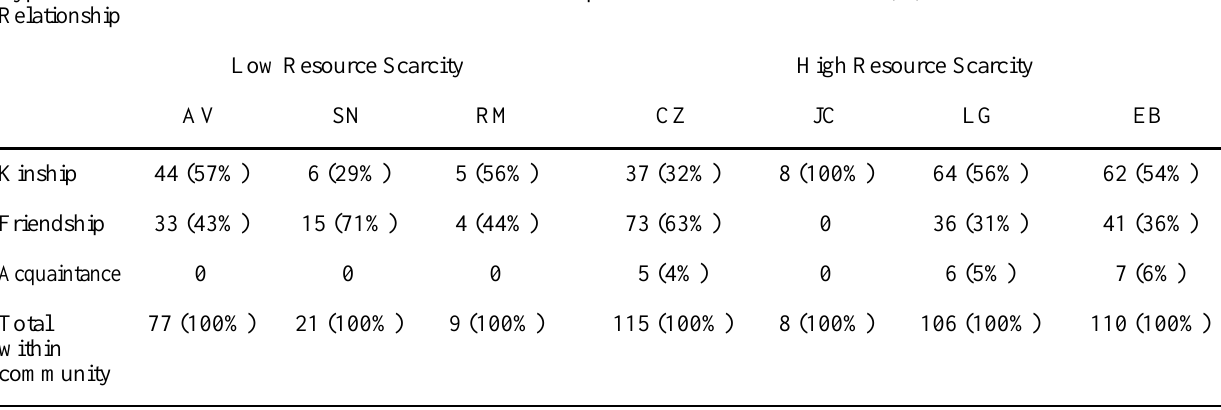
Type of Network Composition within Communities (%) Relationship Low Resource Scarcity High Resource